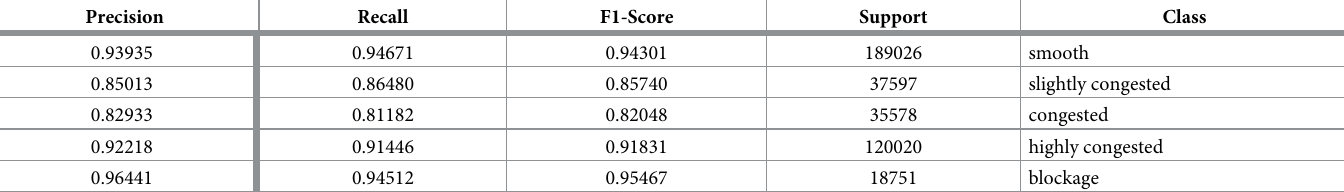
Table 4. Accuracy report for random forest.